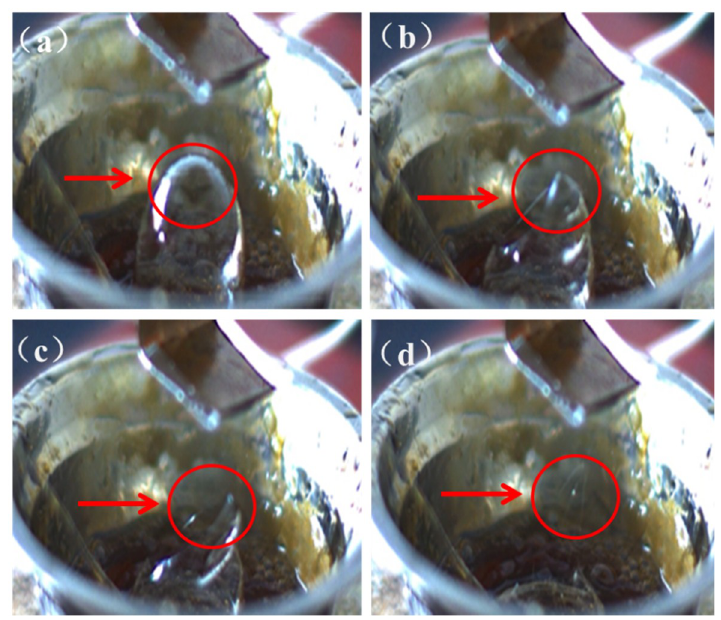
Figure 2. The photos of the unstable bubble and the burst bubble formed fibers: ( a ) the bubble formed; ( b ) the bubble burst; ( c ) the conical tip uplifted; and ( d ) the fibers formed.